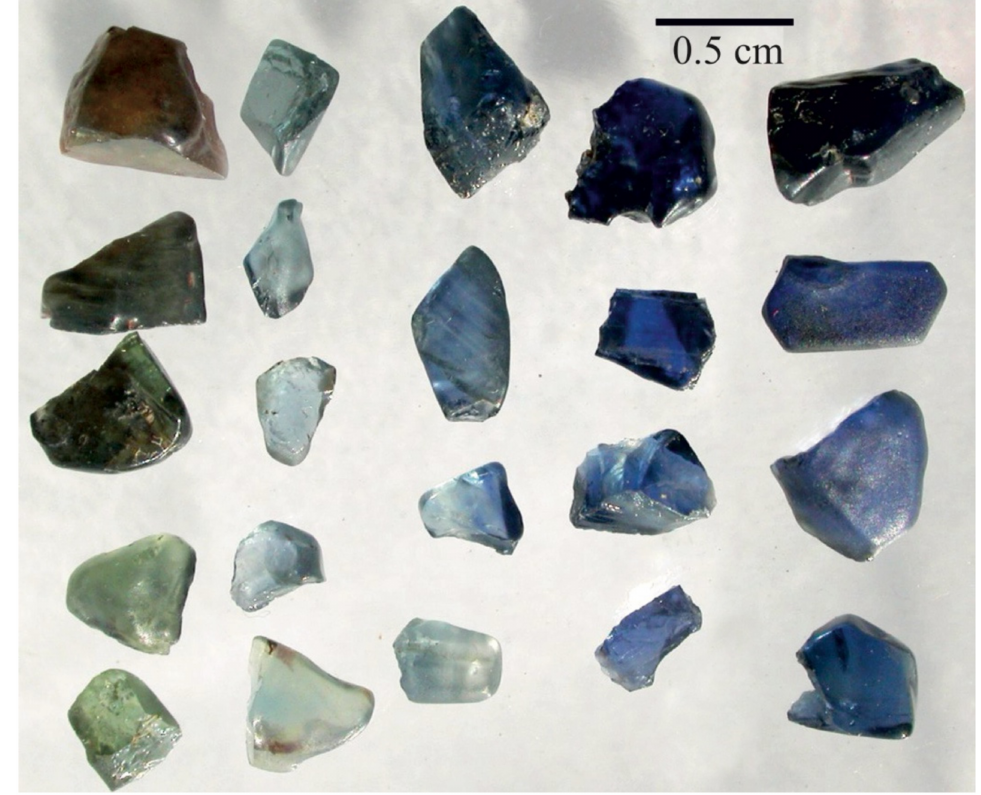
Figure 5. The 22 stone collection of the Naryn-Gol placer sapphires. In addition, sectoral (trapiche) corundums were found (Figure 6). The trapiche- patterned stone has a dark blue color and is translucent. Hexagonal growth is also observed. The core of the sample is colorless. The trapiche has six white symmetri- cal radial patterns contrasted with the blue body color. The size of biggest sapphire is 1.7 cm × 1.2 cm × 0.7 cm. Earlier trapiche sapphires of metamorphic origin were